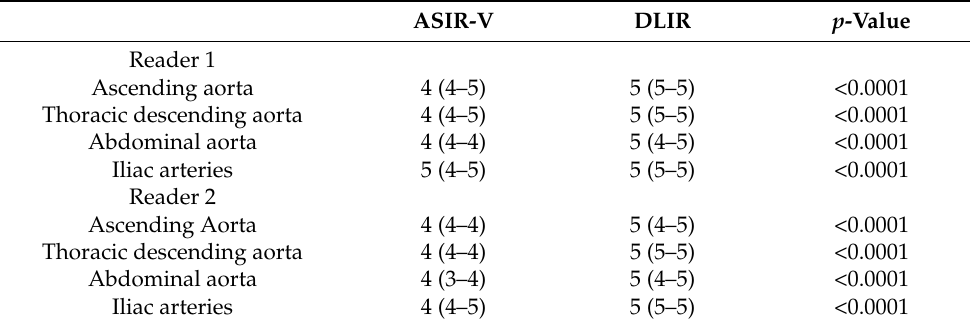
Table 5 subjective image quality was scored on a 5-point scale (5 = excellent, 4 = good, 3 = sufficient, 2 = poor, 1 = non-diagnostic). Data are shown as the median (25–75 percentile). ASIR-V = adaptive statistical iterative reconstruction V, DLIR = deep learning-based image